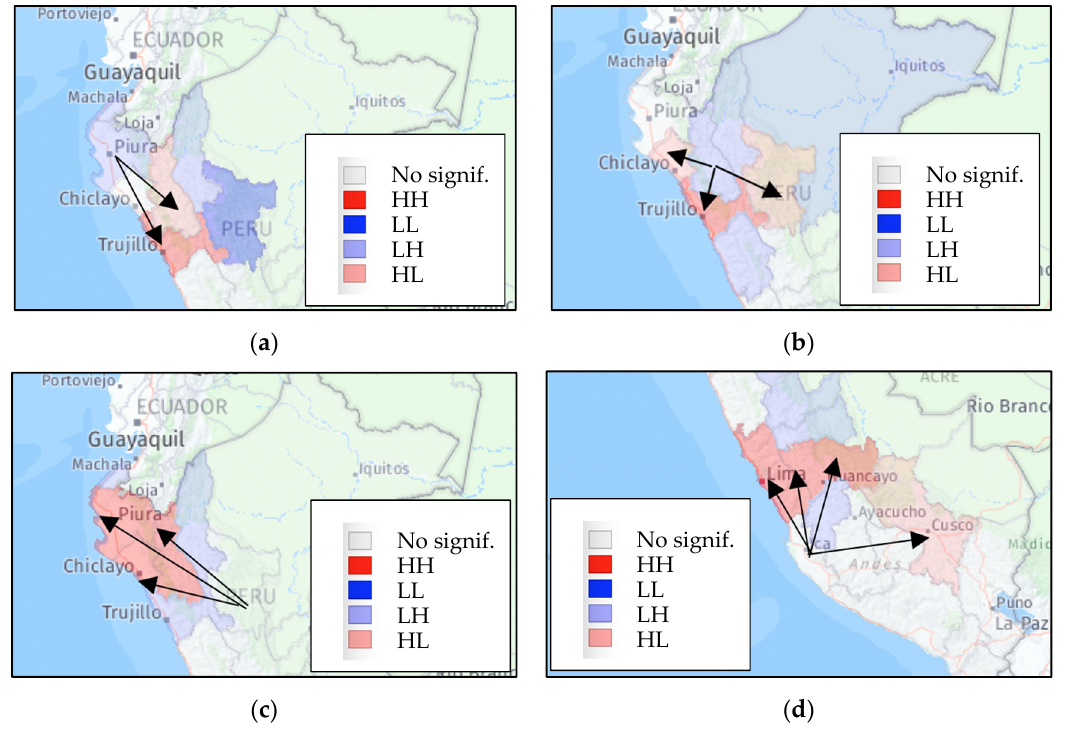
Figure 2. Clusters in destination regions created by origin regions: ( a ) Origin: Piura; ( b ) Origin: Cajamarca; ( c ) Origin: San Martín; ( d ) Origin: Ica.